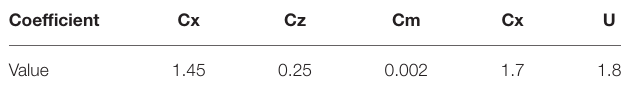
TABLE 4 | Coefficients for wind